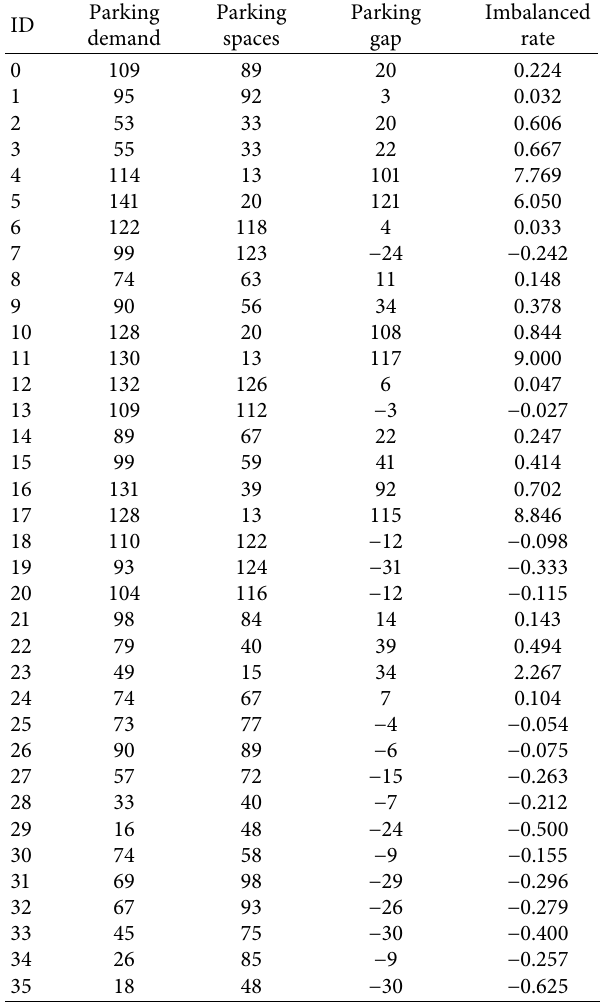
Table 1: The parking resource and imbalanced rate in each